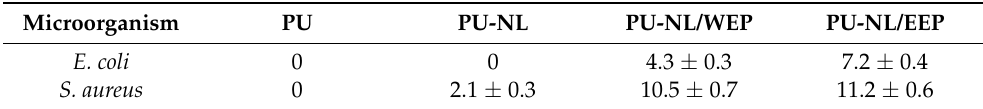
Table 2. Antibacterial activity of the PU, PU-NL, PU-NL/WEP, and PU-NL/EEP films according to the zone of inhibition